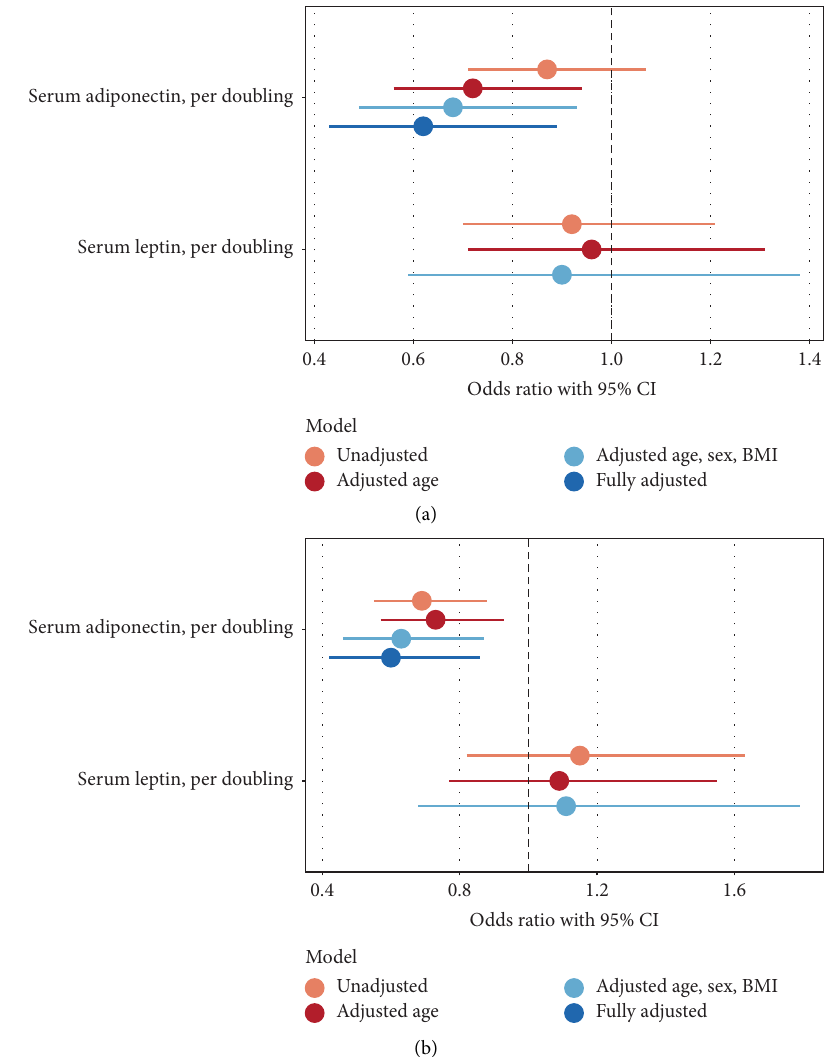
Figure 1: Forest plots of the association between adipokines and 90-day mortality (a) and respiratory failure (b) in patients hospitalized with COVID-19. Fully adjusted (only adiponectin): adjusted for age groups, sex, BMI, hypertension, diabetes, chronic obstructive pulmonary disease, and oxygen saturation at admission. As adiponectin and leptin were log2-transformed prior to analysis, the estimated odds ratio corresponds to the odds ratio associated with a doubling of circulating adiponectin and leptin levels. BMI: body mass index, CI: confdence